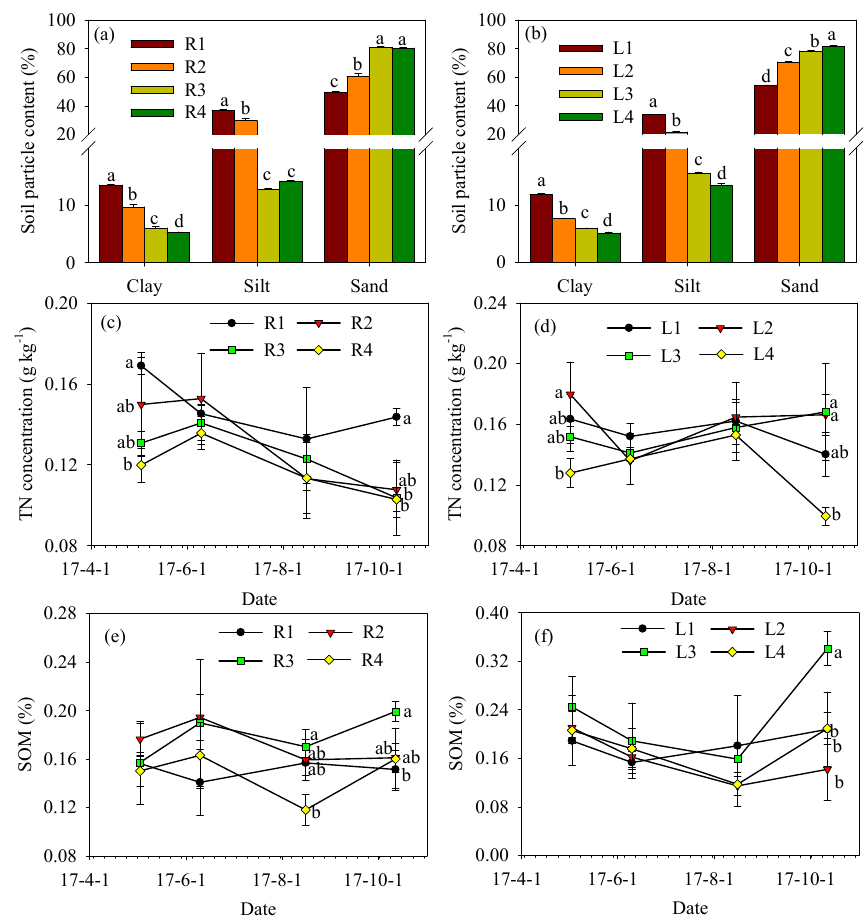
Figure 4. Soil particle content ( a , b ), TN concentration ( c , d ), and SOM content ( e , f ) in different treatments. Different lowercase letters indicate significant differences among the different treatments.